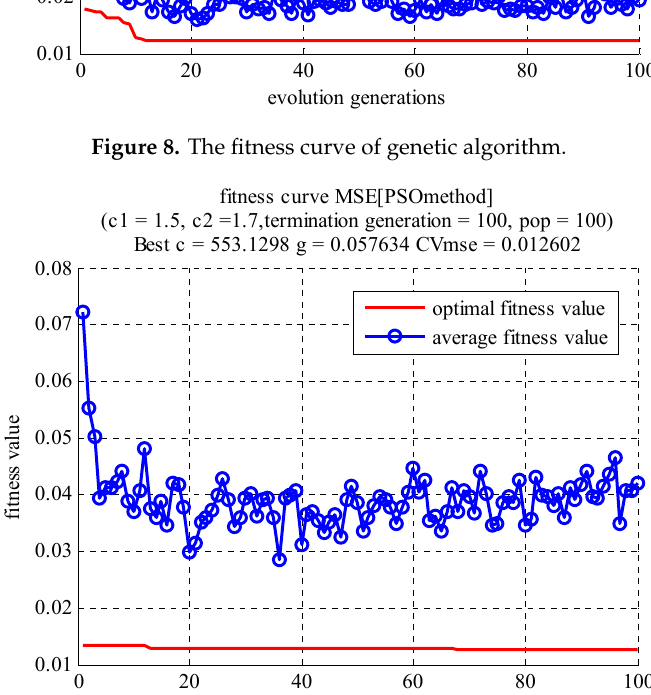
Figure 9. The fitness curve of particle swarm optimization algorithm.